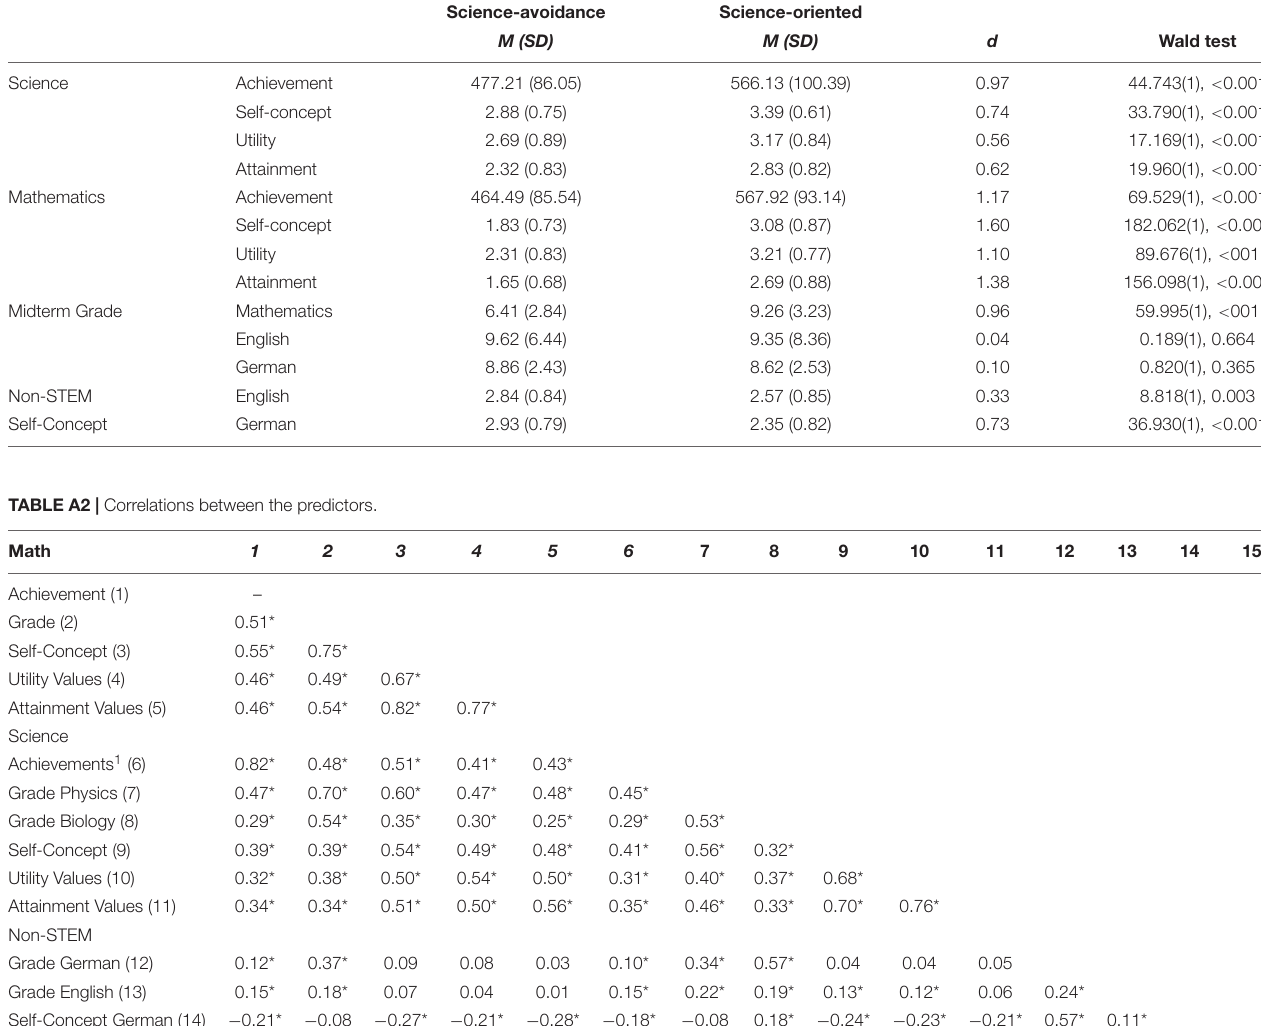
TABLE A1 | Means, standard deviation, effect sizes, and Wald test results for abilities, midterm grades, expectancy value variables in Science and Mathematics as well as English and German midterm grades and ability self-concept across the Science-oriented and Science-avoidance group. Constructs